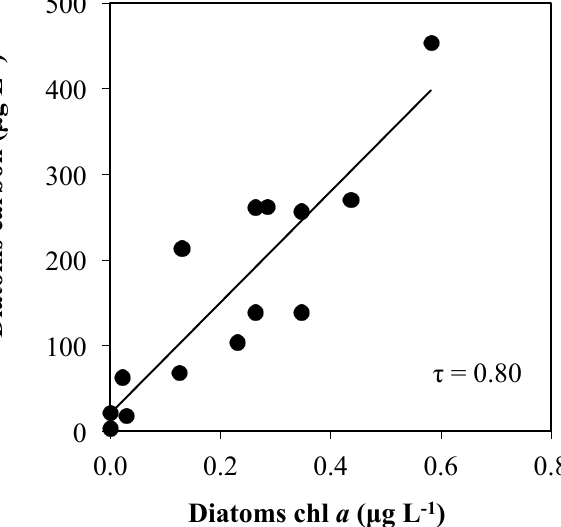
Fig. 5. Comparisons between chl a levels and carbon derived from